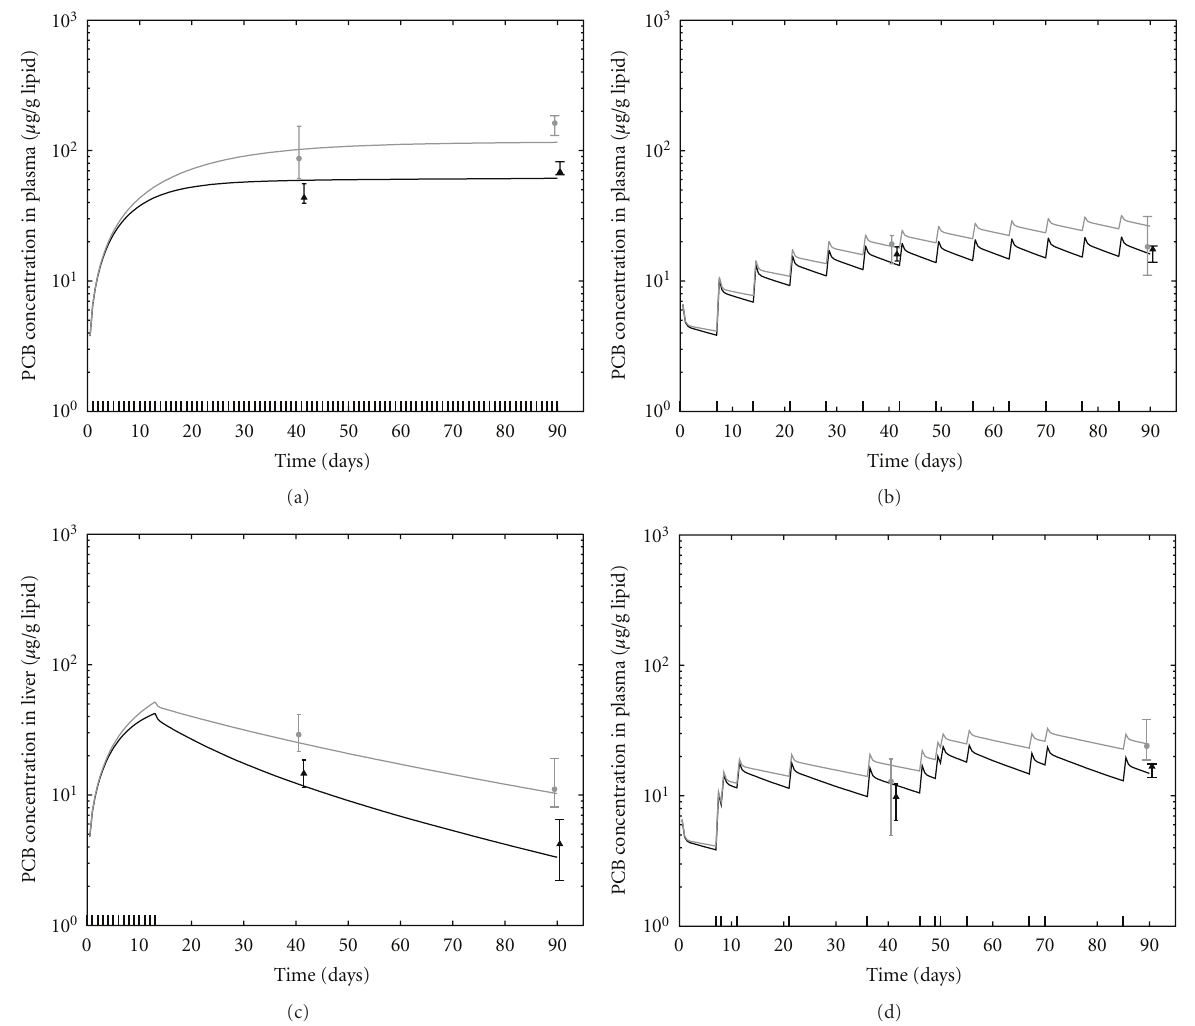
Figure 3: Model predictions and data for all PCBs at the 500 μ g/kg dose level and the four dose protocols. Data represents the median measurements across rats at time of sacrifice (grey circle: all multi-ortho PCBs, black triangle: PCB 118). Modeled results are for the median over all multi-ortho PCBs (grey line), and the median results for PCB 118 (black line), resulting from 1000 model runs using parameters randomly sampled from the posterior